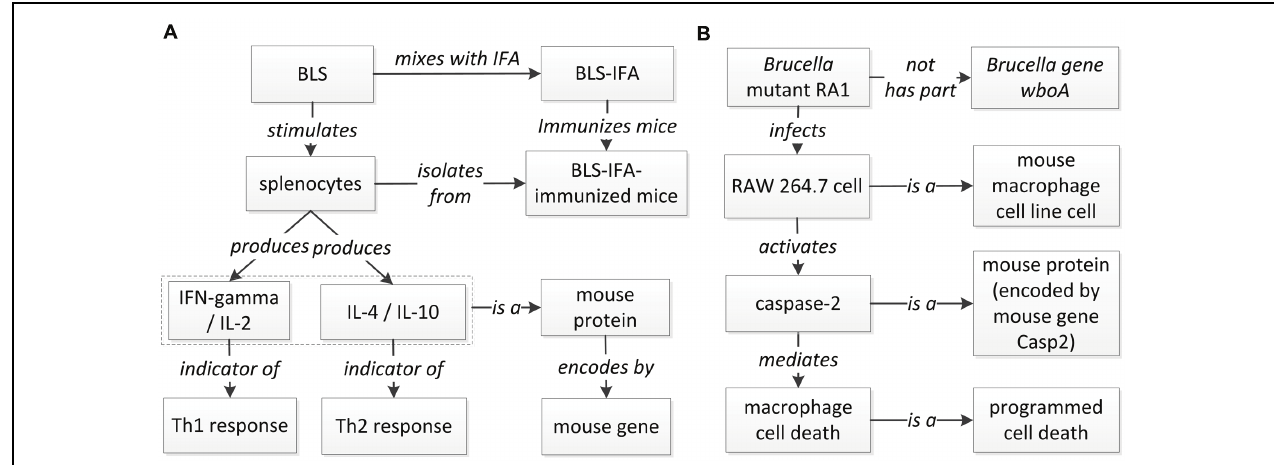
FIGURE 6 | Ontology modeling of literature-mined host- Brucella interaction types. (A) Ontology modeling of the gene interaction from the sentence “In addition, after in vitro stimulation with rBLS, spleen cells from BLS-IFA-, BLS-Al-, or BLS-MPA-immunized mice proliferated and produced interleukin-2 (IL-2), gamma interferon (IFN-gamma), IL-10, and IL-4, suggesting the induction of a mixed Th1-Th2 response” (Velikovsky et al., 2003). (B) Ontology modeling of the Casp2-wboA gene interaction using the abstract content from the paper (Chen and He,